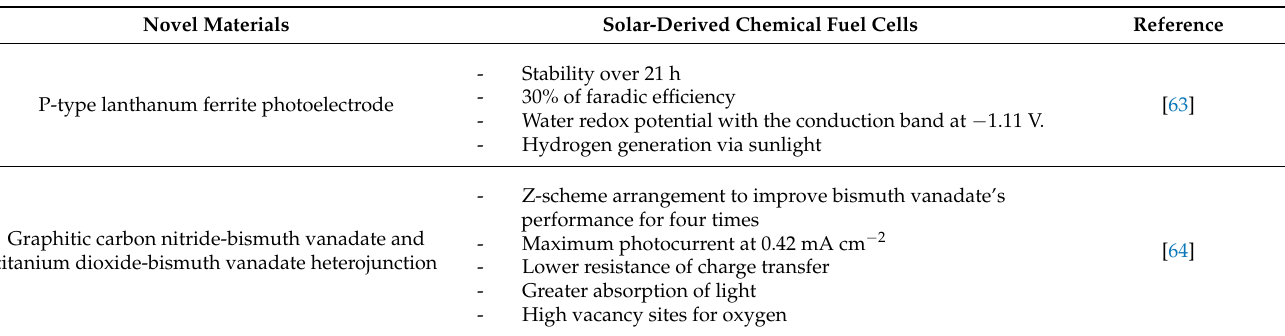
Table 1. Novel materials for the preparation of solar-derived chemical fuel cells and their exclu- sive